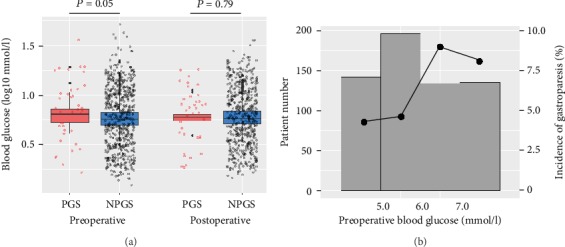
Blood glucose and PGS characteristics. (a) Distribution of preoperative and postoperative blood glucose between PGS and NPGS. (b) Frequency distribution of patients and PGS incidence of different blood glucose strata.